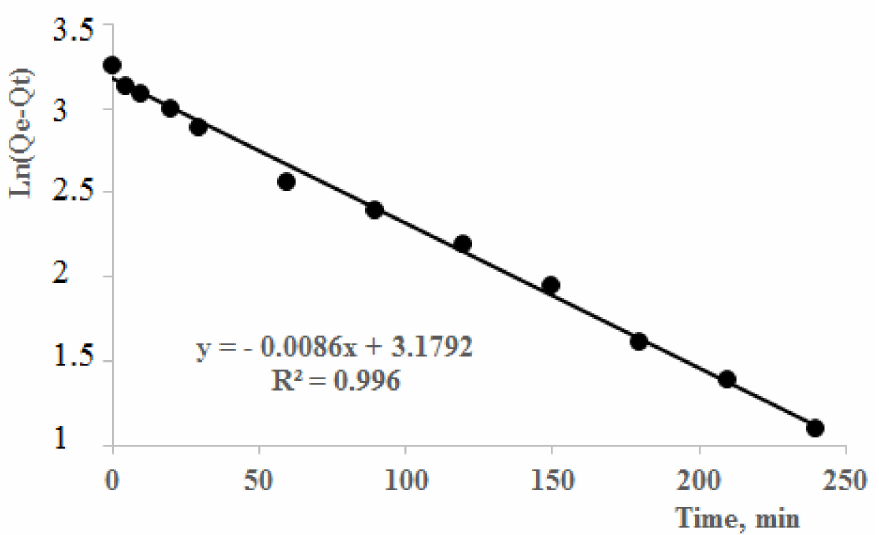
Figure 7. Pseudo-first-order models isotherms for Pb(II) removal by DMAA–AMPS hydrogel. Condi- tions: mass of dry hydrogel 100 mg; concentration of solution 30 mg/L and 25 ◦ C. Hydrogel (50–50% DMAA–AMPS molar ratio, initiator concentration 0.07% of total monomer mass, 0.74% crosslinker, total monomer concentration 5 M) was used.